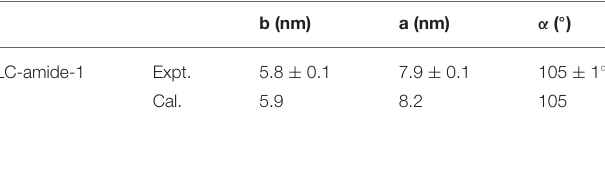
TABLE 1 | Experimental (Expt.) and calculated (Cal.) cell parameters of LC-amide-1 at high concentration on the HOPG surface.